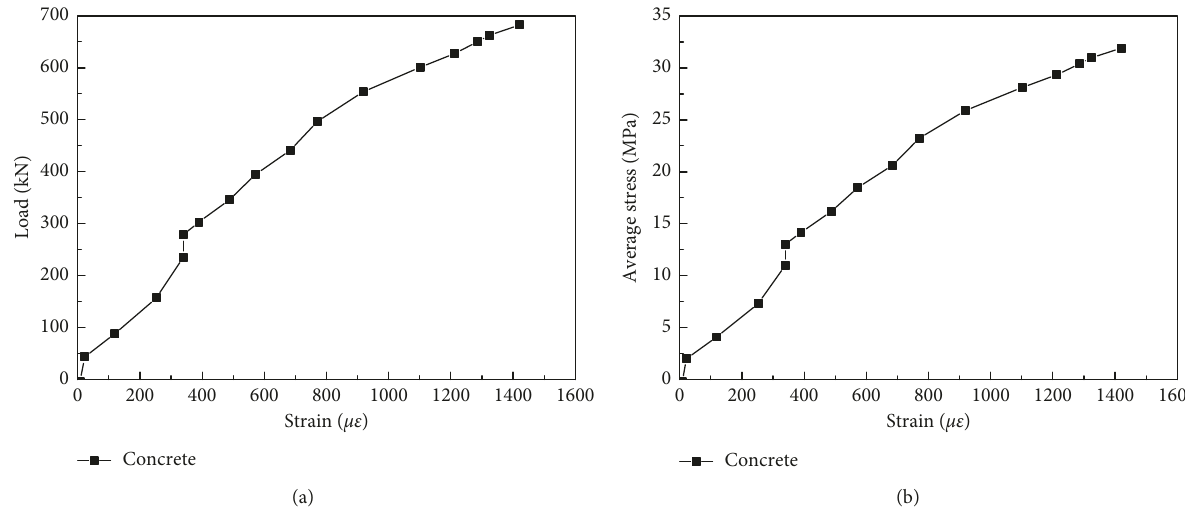
Figure 13: Axial compressive strain development of core concrete of specimen RS-A-2. (a) Relationship of vertical strain development with load. (b) Relationship of vertical strain development with average stress.